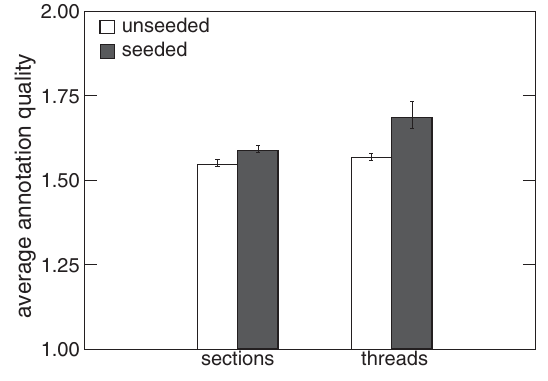
FIG. 5. Average quality of annotations in unseeded versus seeded sections (left) and in unseeded versus seeded threads